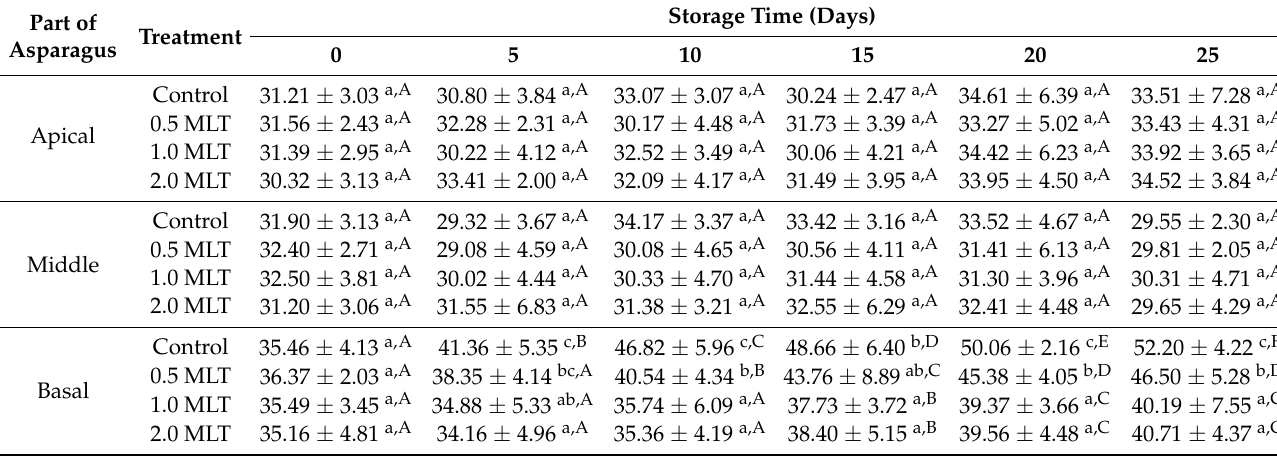
Table 1. Effect of melatonin treatment on firmness (N) at the apical, middle, and basal parts of green asparagus during 25 days of storage at 4 ◦ C and 90% relative